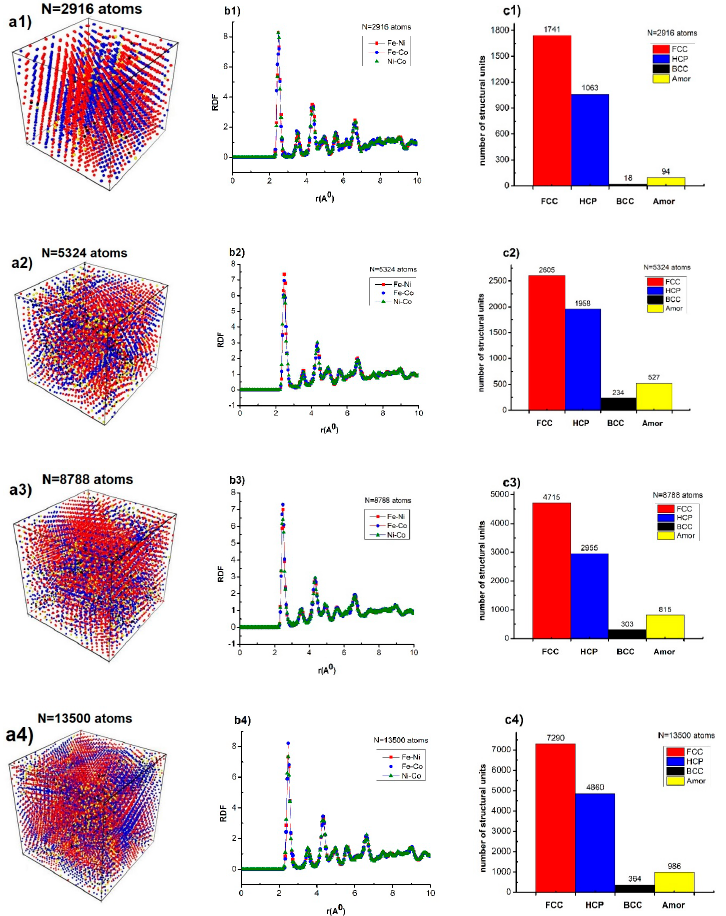
Figure 3. Structure shape ( a1 – a4 ), RDF ( b1 – b4 ), number of structural unit ( c1 – c4 ) of Fe 63 Ni 32 Co 5 alloy at T = 300 K, P = 0 GPa with different numbers of atoms.